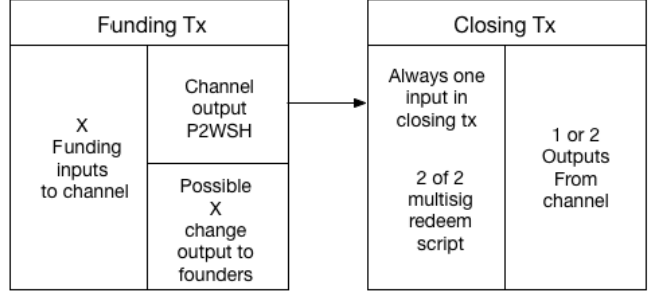
Figure 4. Channel graph with funding and closing